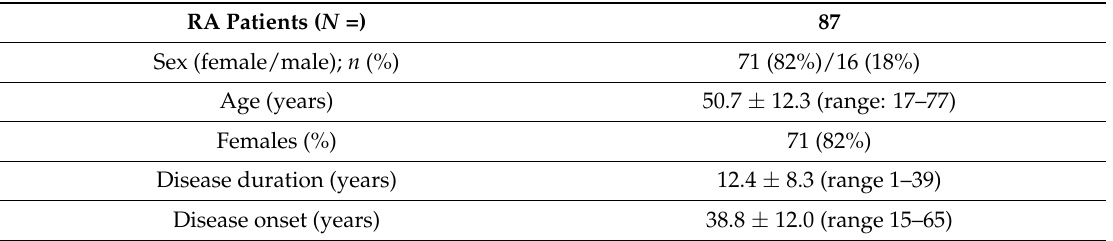
Table 1. Characteristics of RA patients for whom associations of single nucleotide polymorphisms with disease progression and response to therapy with TNF- α inhibitors were